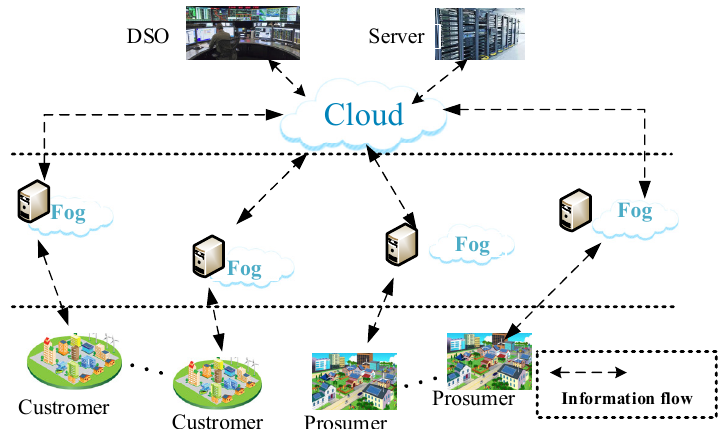
Figure 1. Cloud-fog based energy management architecture. DSO: distribution system Figure 1 . Cloud-fog based energy management architecture. DSO: distribution system operator .